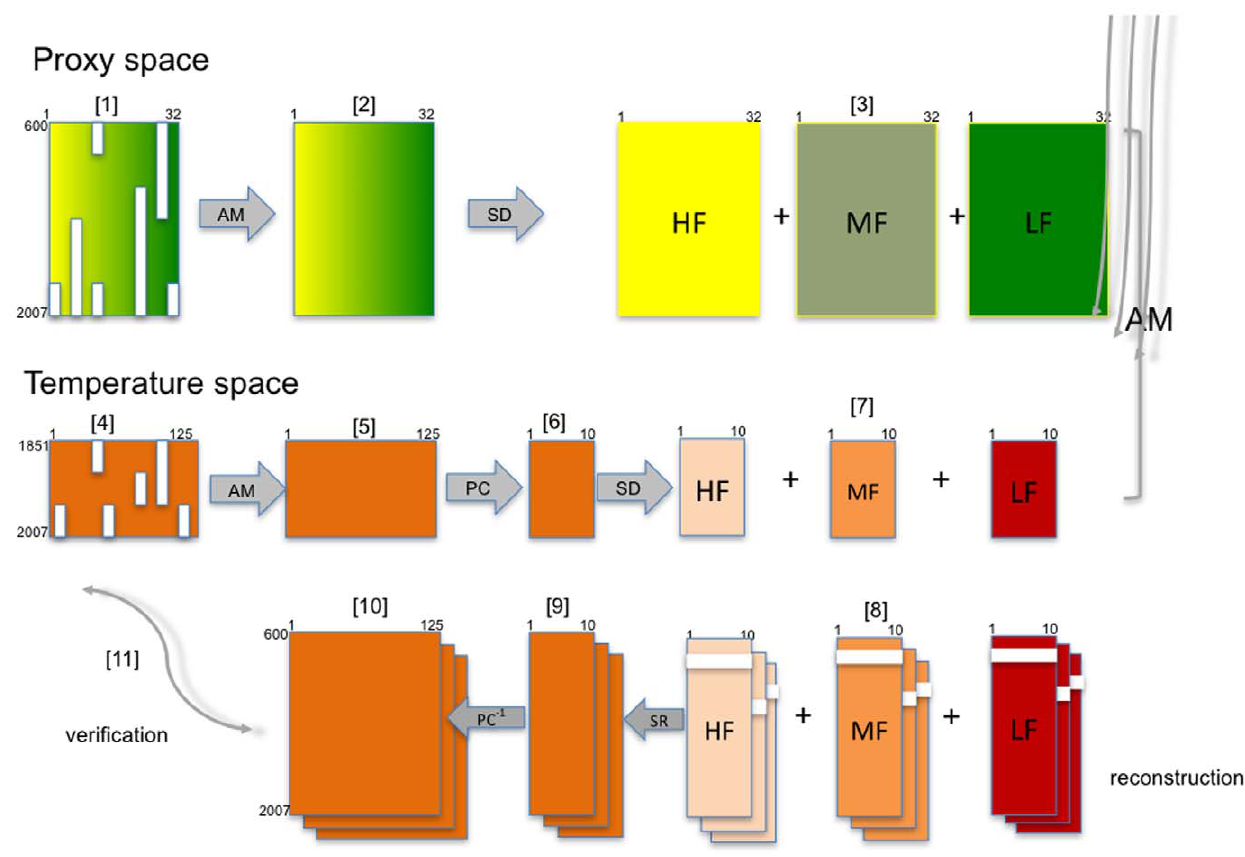
Figure 2. Schema of the reconstruction method (see text for more details). Abbreviations: AM, analog method, SD, spectral decomposition, PC, transformation into principal components, SR, spectral recomposition, PC 2 1 , back-tranformation of the principal components into original variables, HF, high frequency, MF, medium frequency, LF, low frequency.